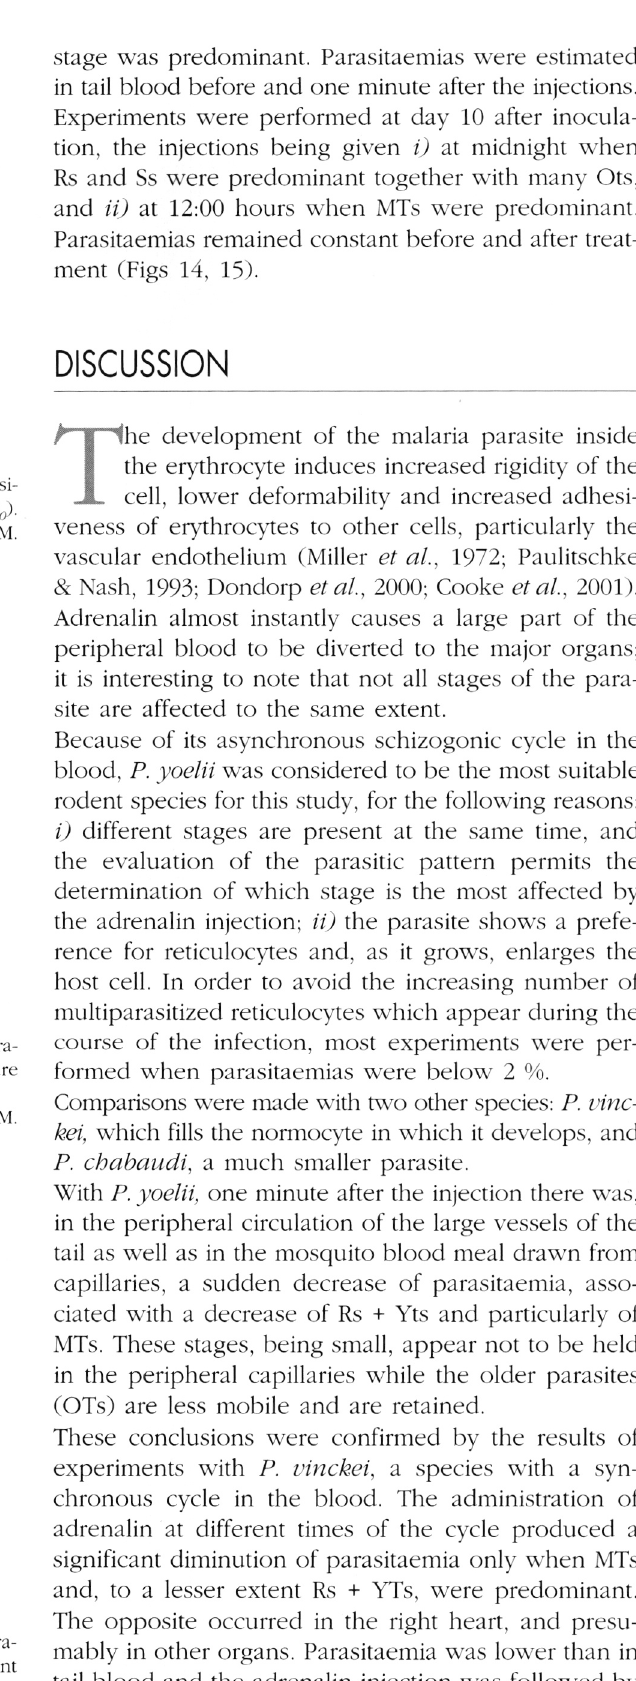
Fig. 15. - P. chabaudi chabaudi: effect of adrenalin injection on para­ sitaemia in mouse tail blood when schizonts (Ss) are predominant (midnight). Box-plots represent parasitaemias and etror bars indicate the